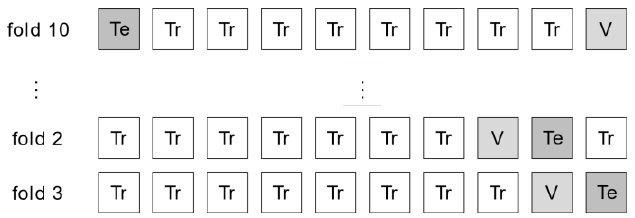
Figure 9. Scheme of 10-fold cross-validation used in this research.